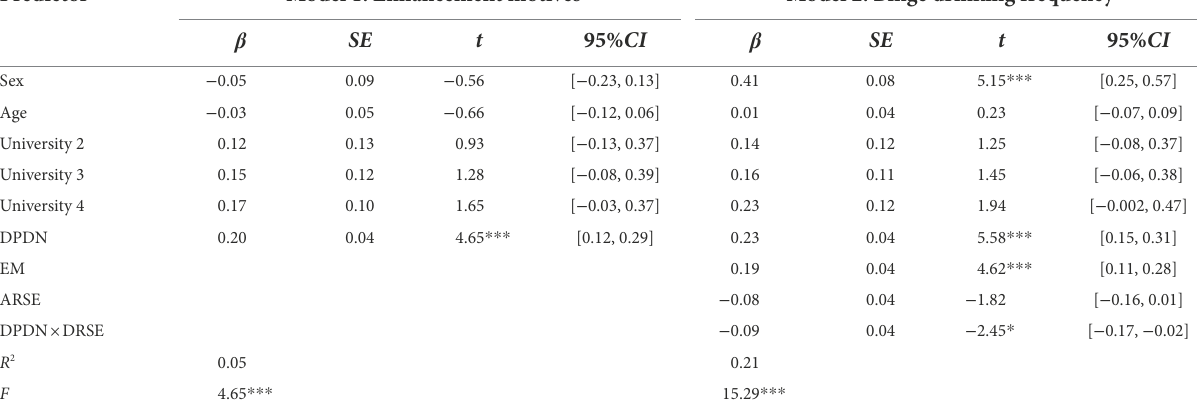
TABLE 2 Testing the mediating effect of enhancement motives and the moderating effect of alcohol resistance self-efficacy in the relation between descriptive peer drinking norms and binge drinking frequency.